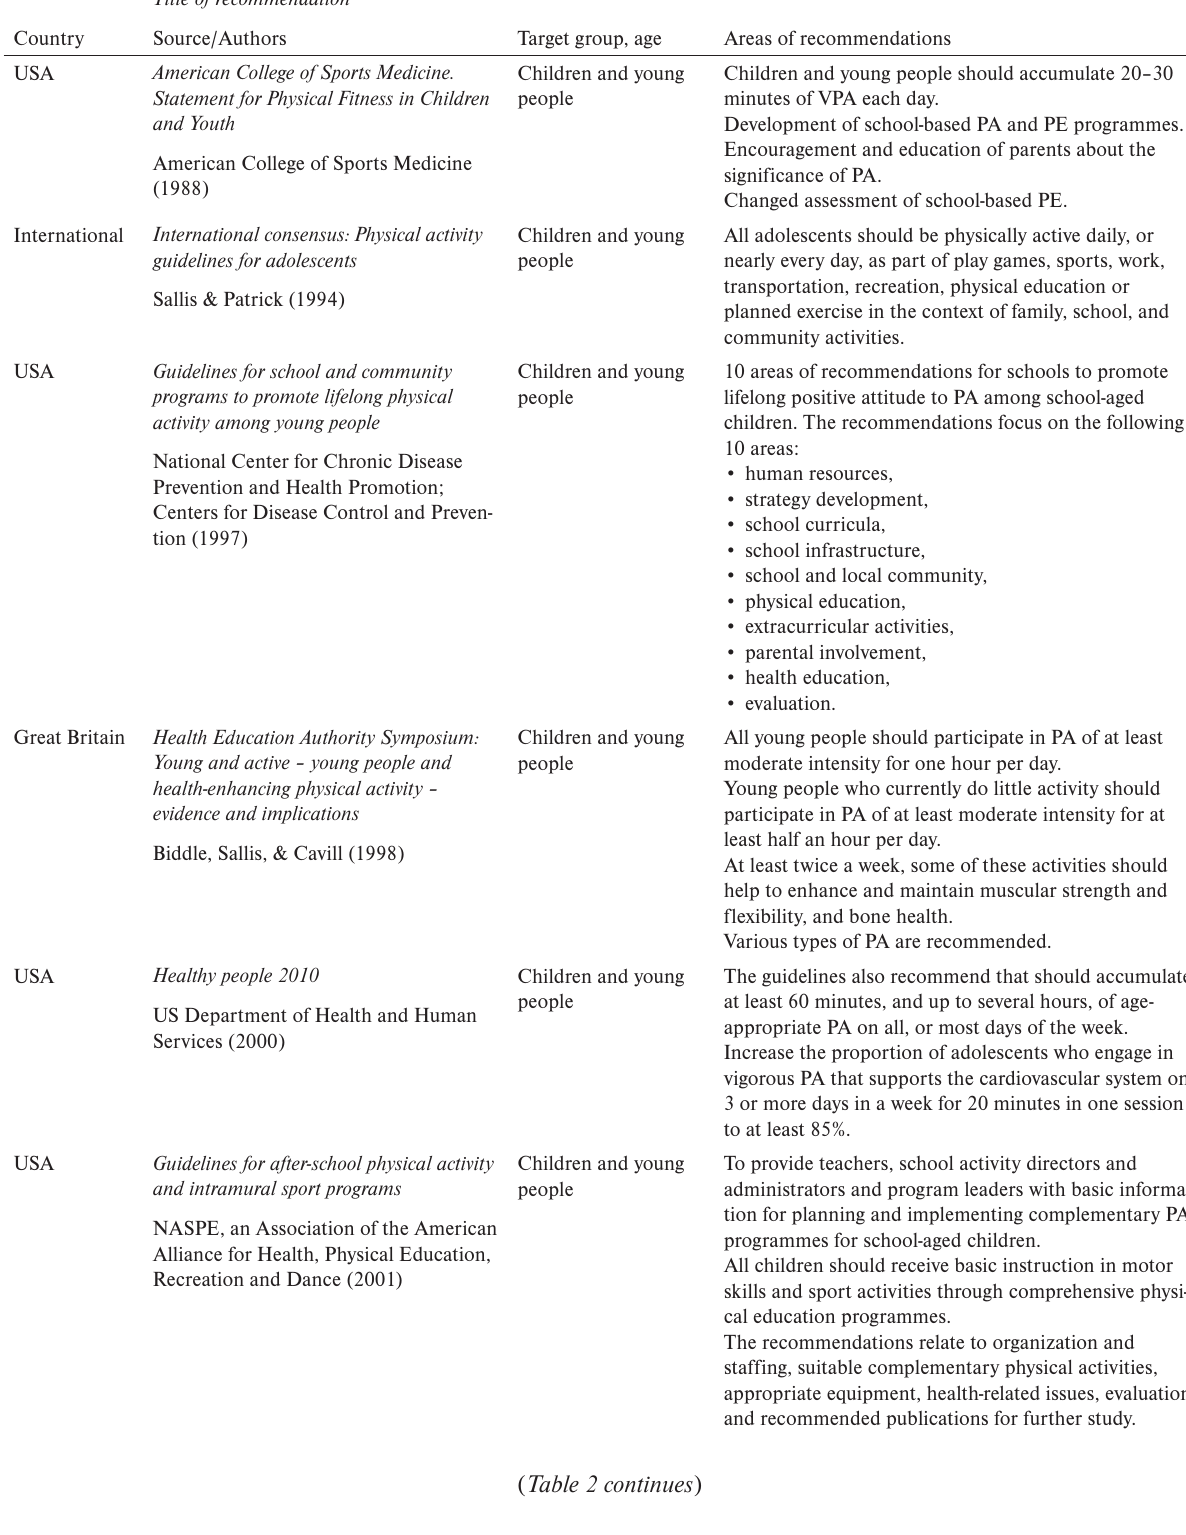
Analysis of foreign recommendations to increase PA in order to promote health in children and young people – ordered